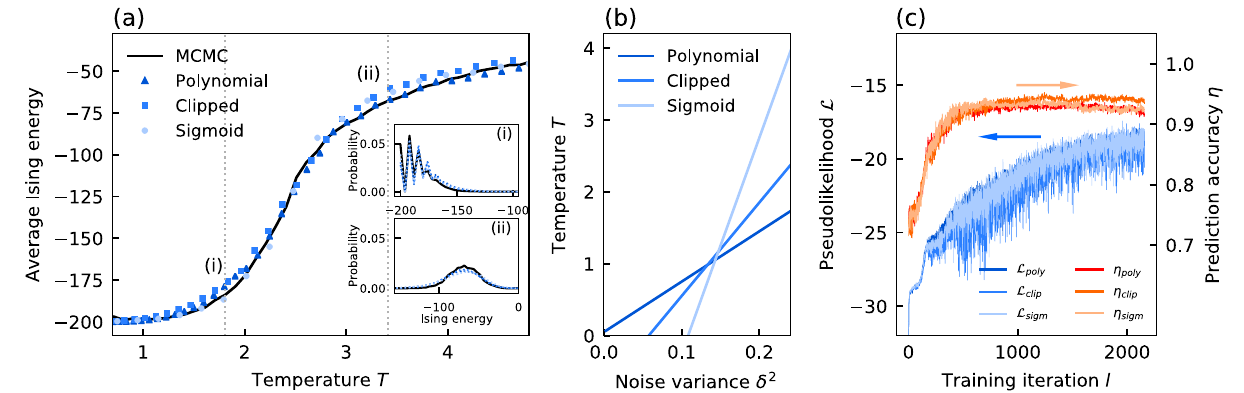
Fig. 8 | Simulated Boltzmann sampling performance of different analog Ising machine models. a Average energy at different temperatures for the 2D Ising model. Samples are obtained with the Metropolis – Hastings algorithm